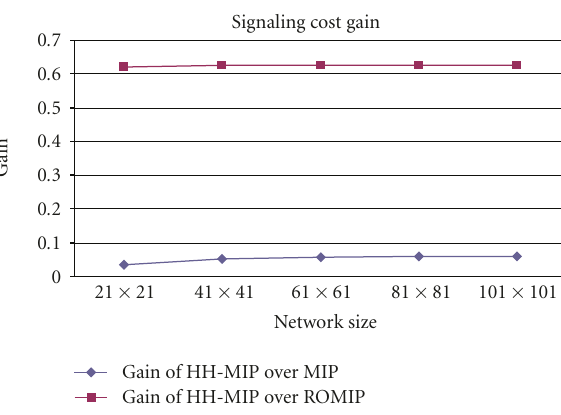
Figure 14: Comparison of signaling cost